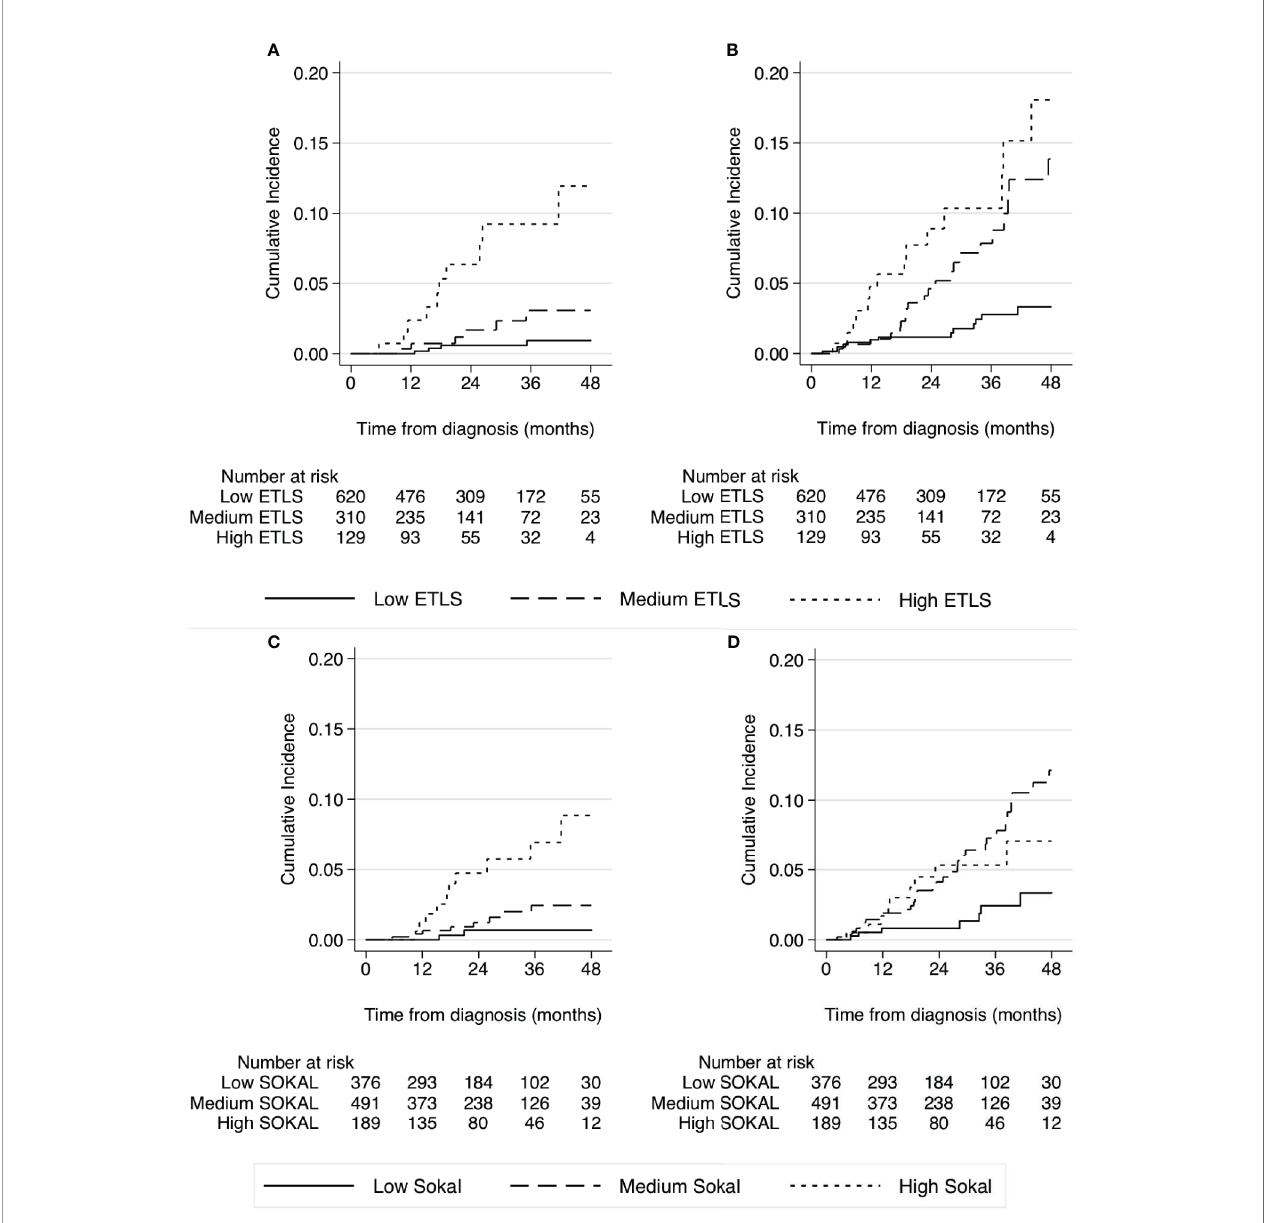
FIGURE 3 | Cumulative incidence of mortality related to CML and other causes of deaths (competing event) by prognostic baseline risk, according to the ELTS (A, B) and Sokal score (C, D)